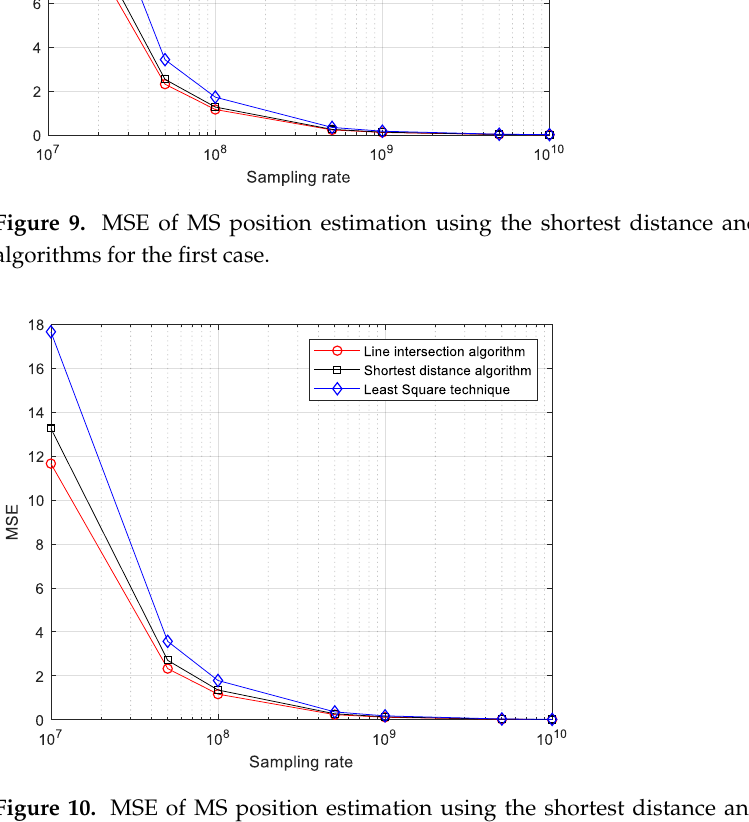
Figure 10. MSE of MS position estimation using the shortest distance and the line intersection algorithms for the second case.